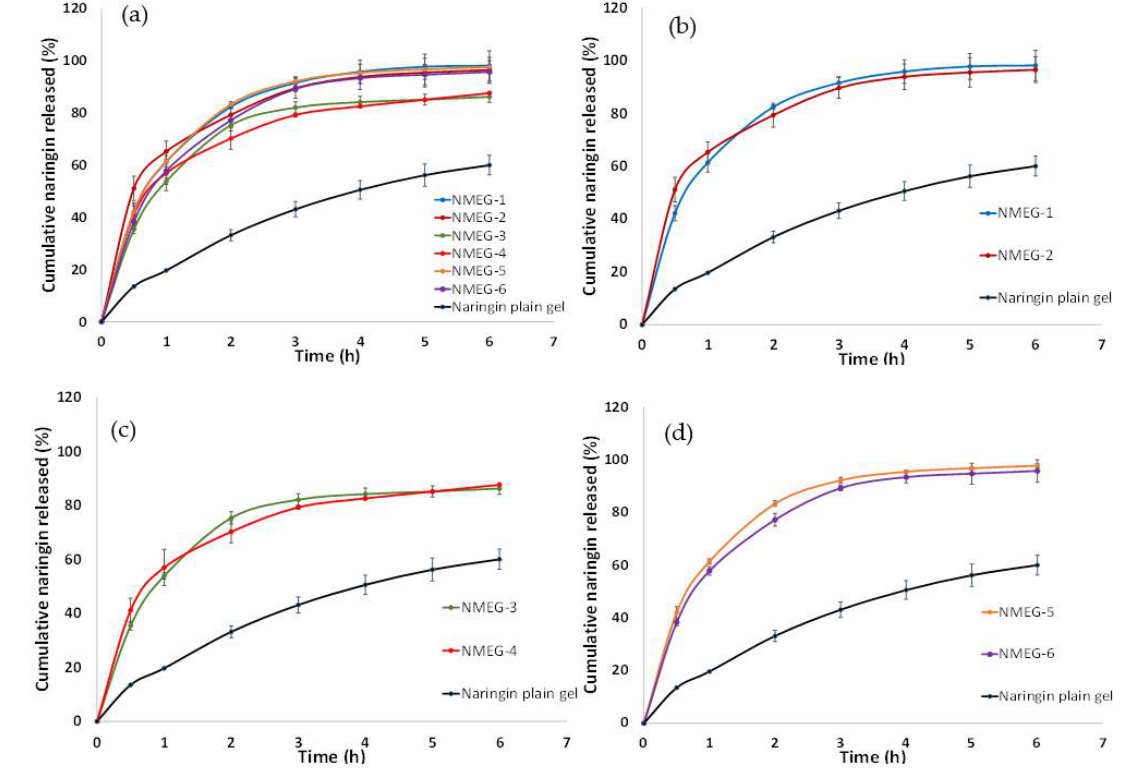
Figure 7. Cumulative release of naringin from ( a ) microemulsion-gel formulations and naringin plain gel; ( b ) NMEG-1 and NMEG-2; ( c ) NMEG-3 and NMEG-4 and ( d ) NMEG-5 and NMEG-6. Each data point represents the mean ± SD (n = 3).